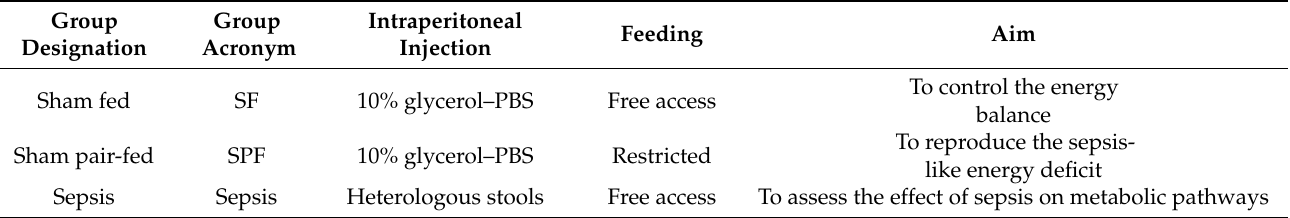
Table 1. Interventions according to the three experimental